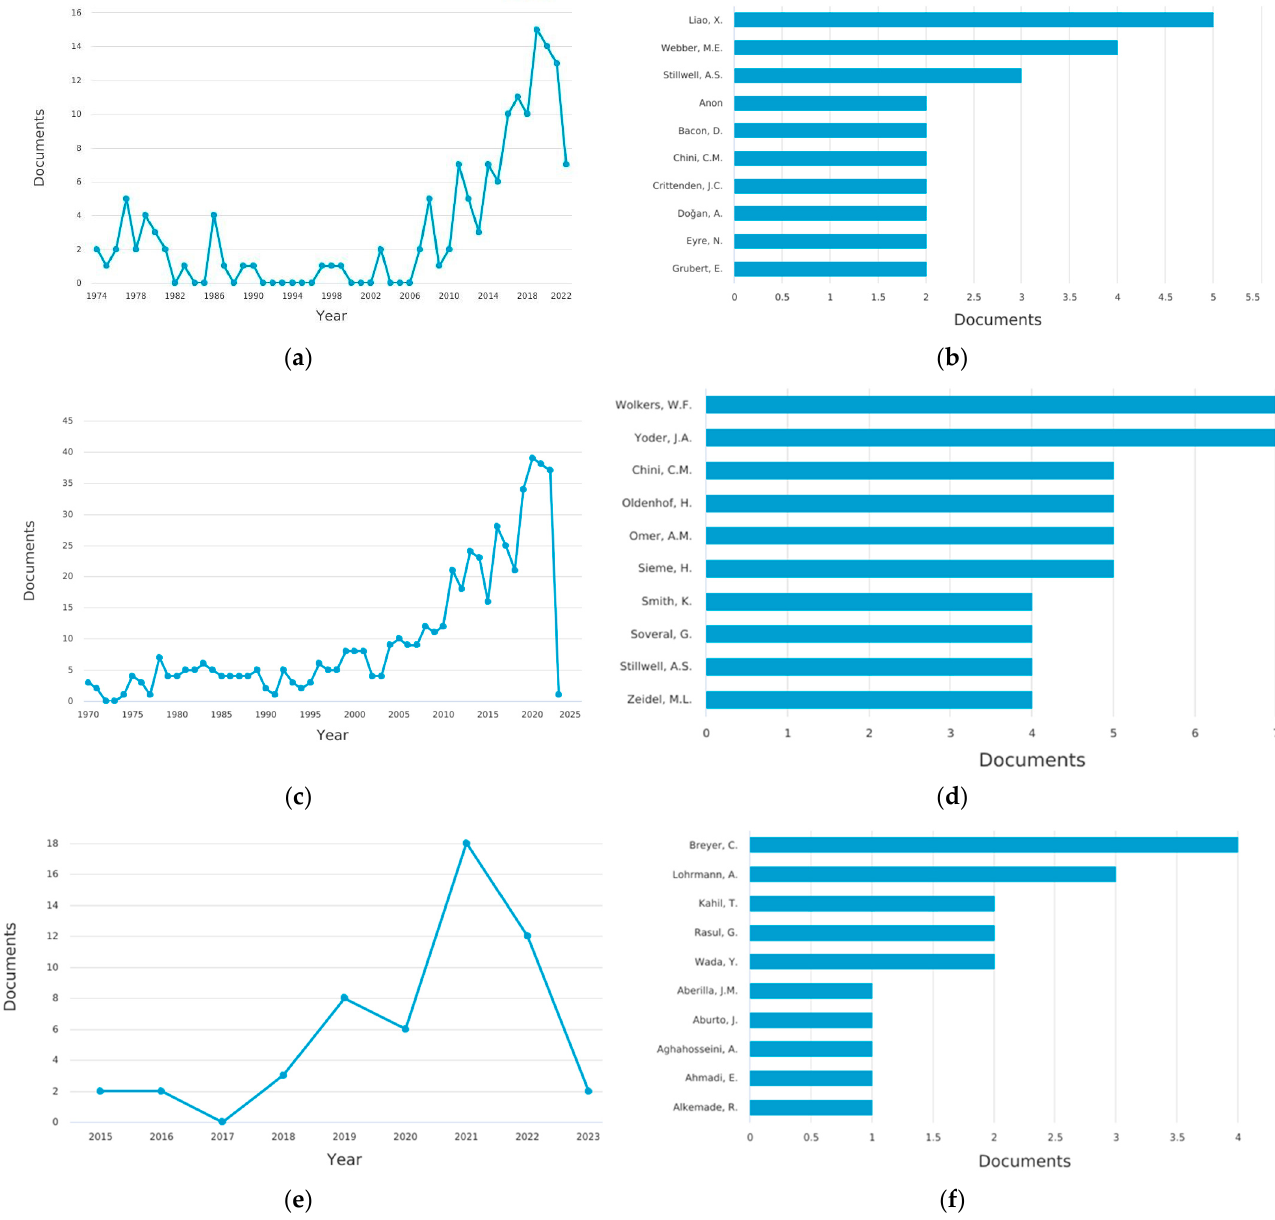
Figure 1. Yearly distribution of papers published, according to the Scopus database, for specific keyword strings (search cases C1, C2 and C3 from Table 1) and production of the most prolific au- thors in the field: ( a , b ) C1 search case (n = 153); ( c , d ) C2 search case (n = 537); ( e , f ) C3 search case (n =